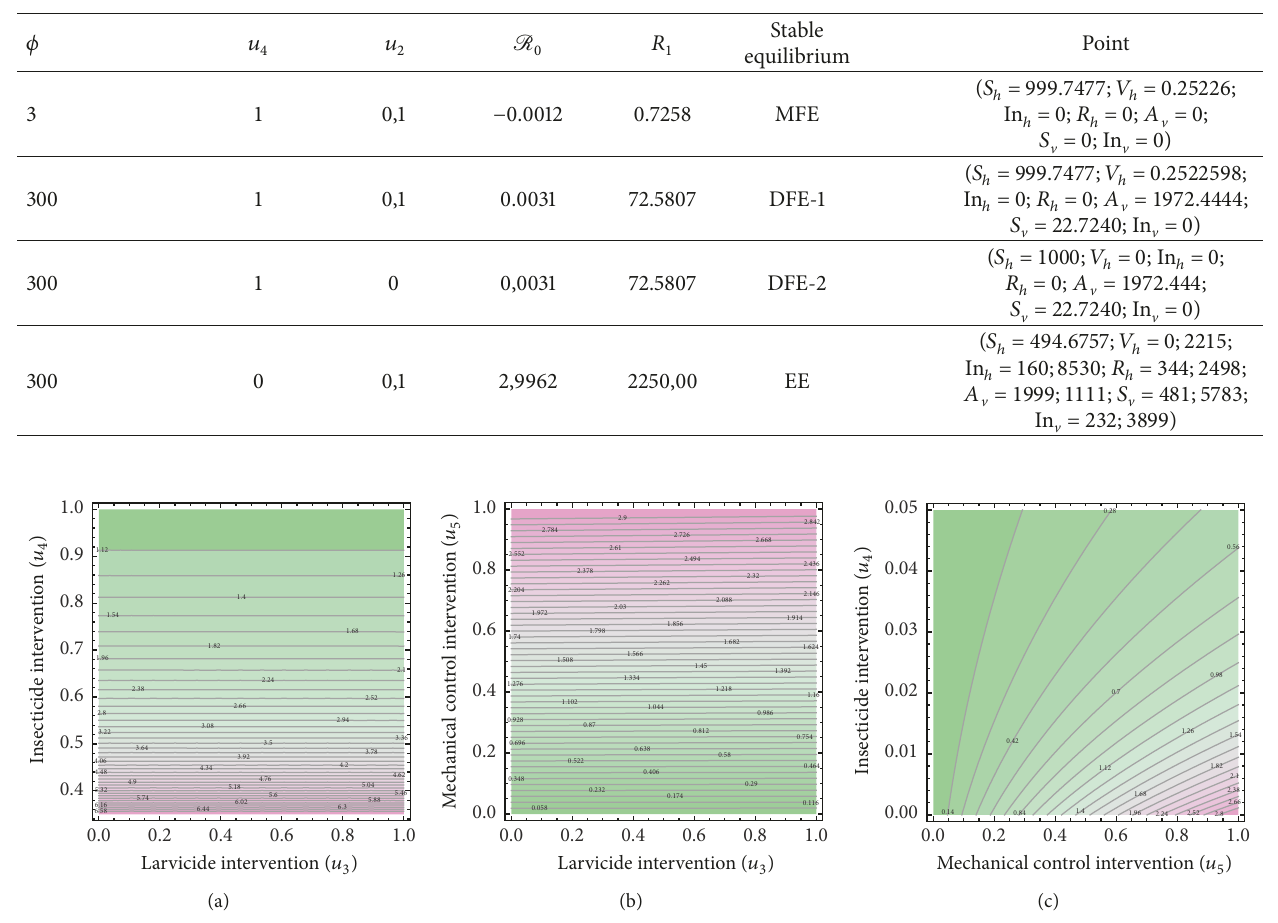
Table 2: Numerical example to show existence and stability of equilibrium points for various values of parameters in Table 1 and 𝑢 1 = 0, 𝑢 3 = 0, 𝑢